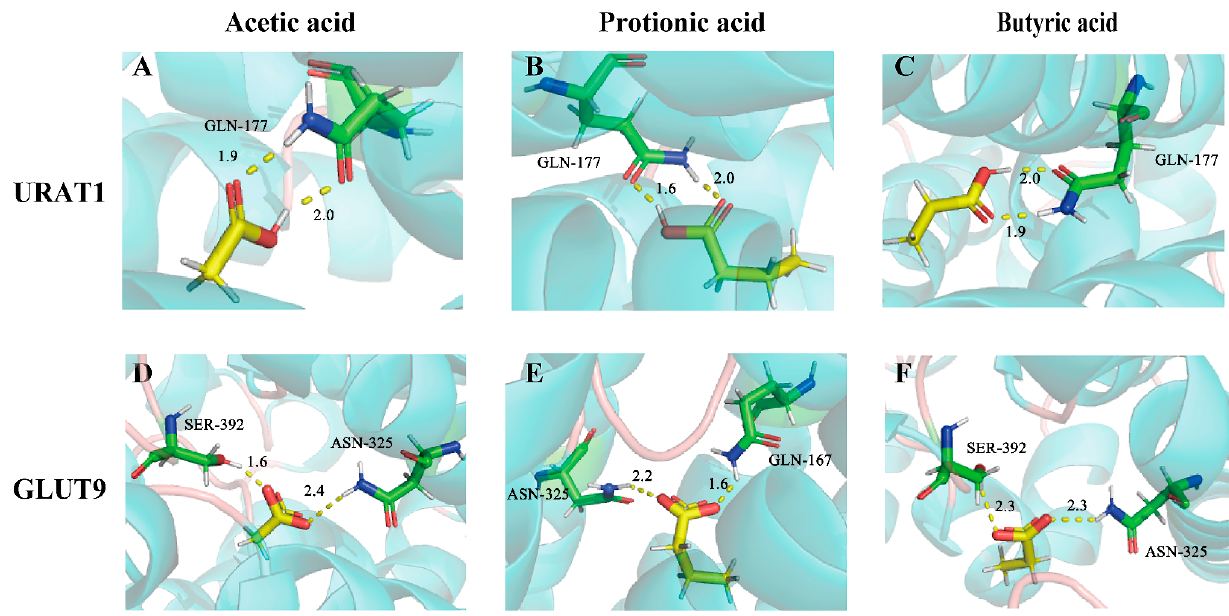
Figure 9. The binding modes of acetic acid, propionic acid, and butyric acid with URAT1 ( A – C ) and GLUT9 ( D – F ).